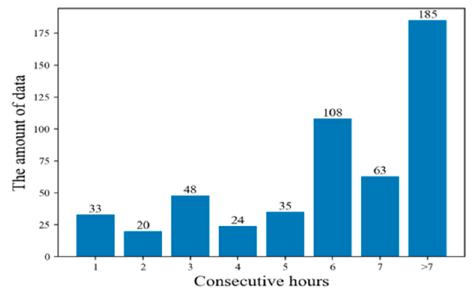
Figure 5. Statistics of segments of continuous missing data.